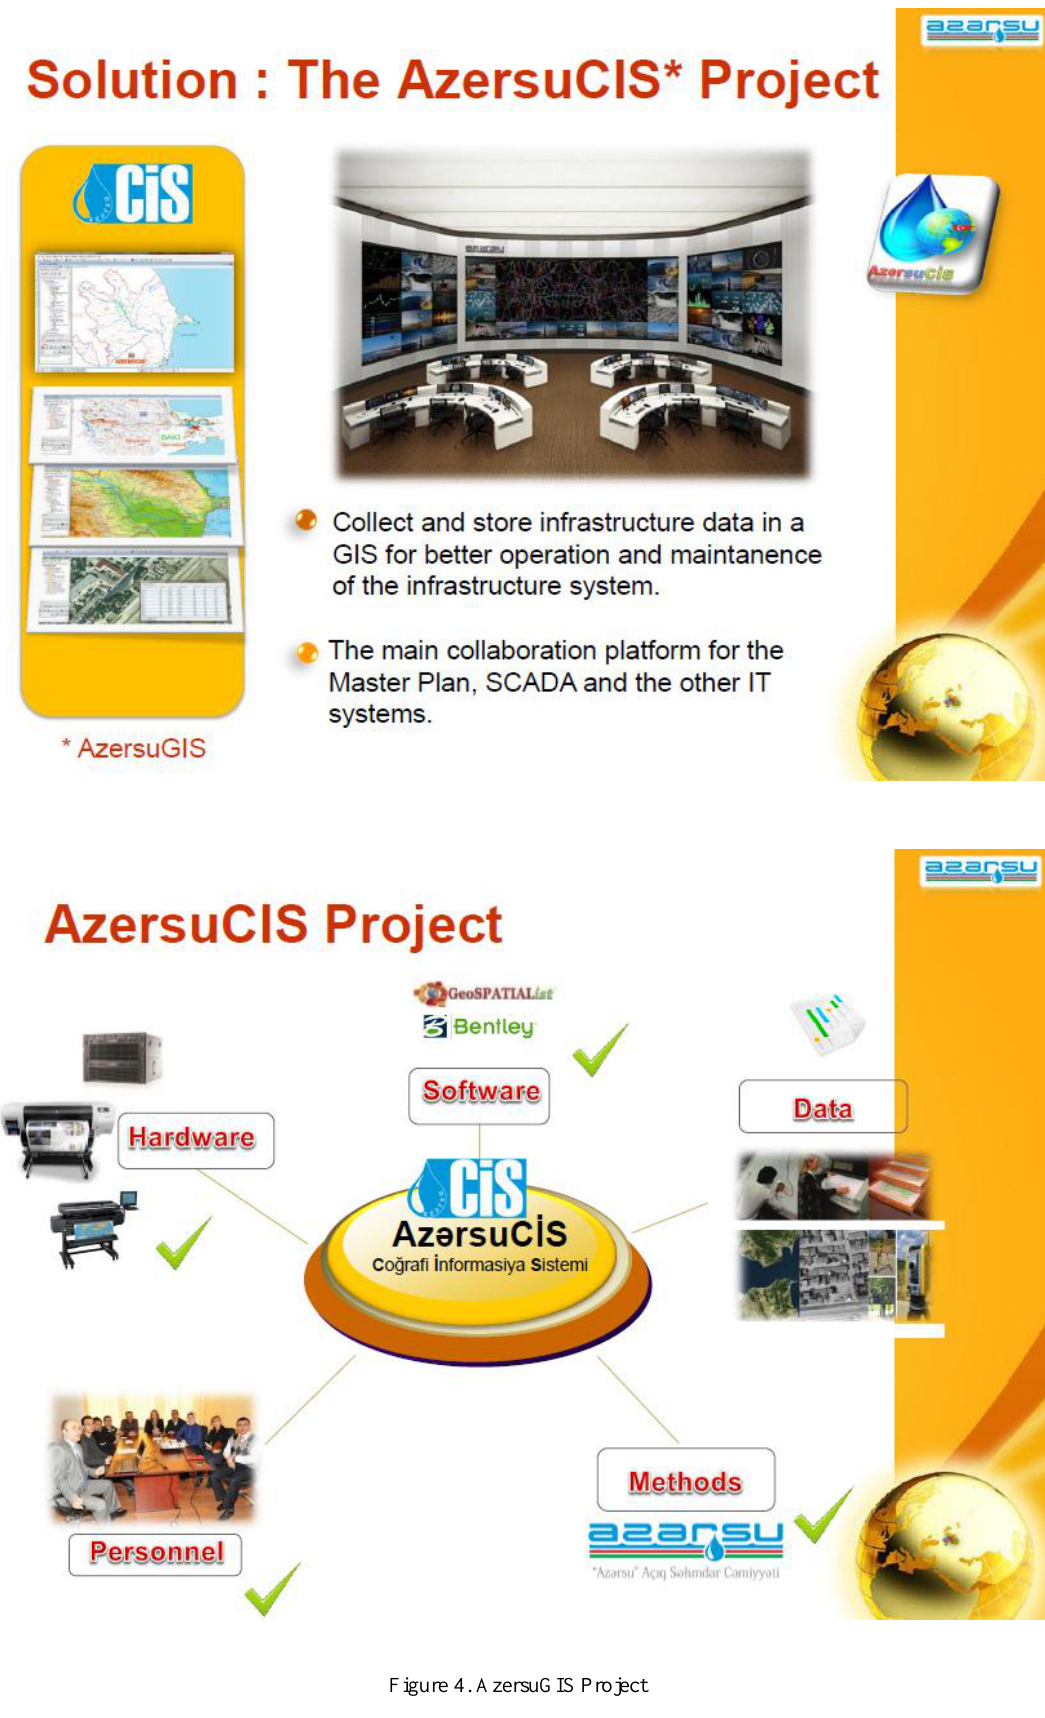
Figure 4. AzersuGIS